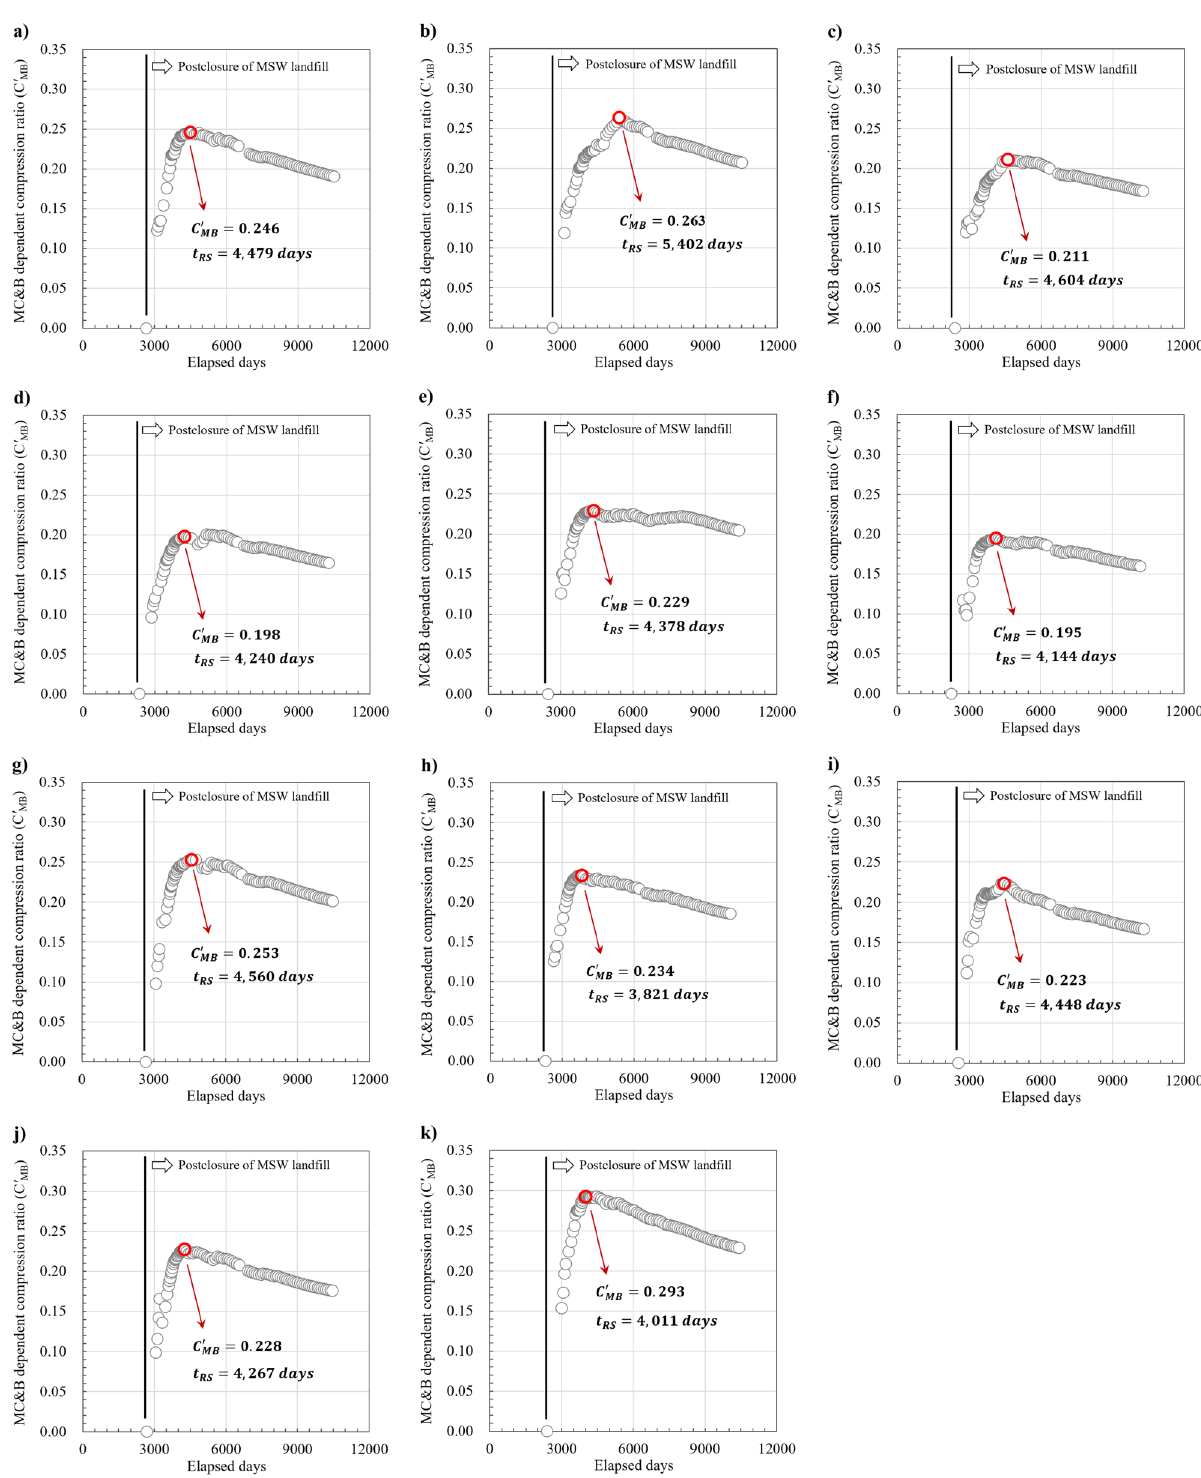
Figure 4. Changes in the compression ratio ( C ′ MB ) coupling mechanical creep and bio-compression to time history, and determination of the starting date ( t RS ) for residual settlement: ( a ) B block; ( b ) C block; ( c ) D